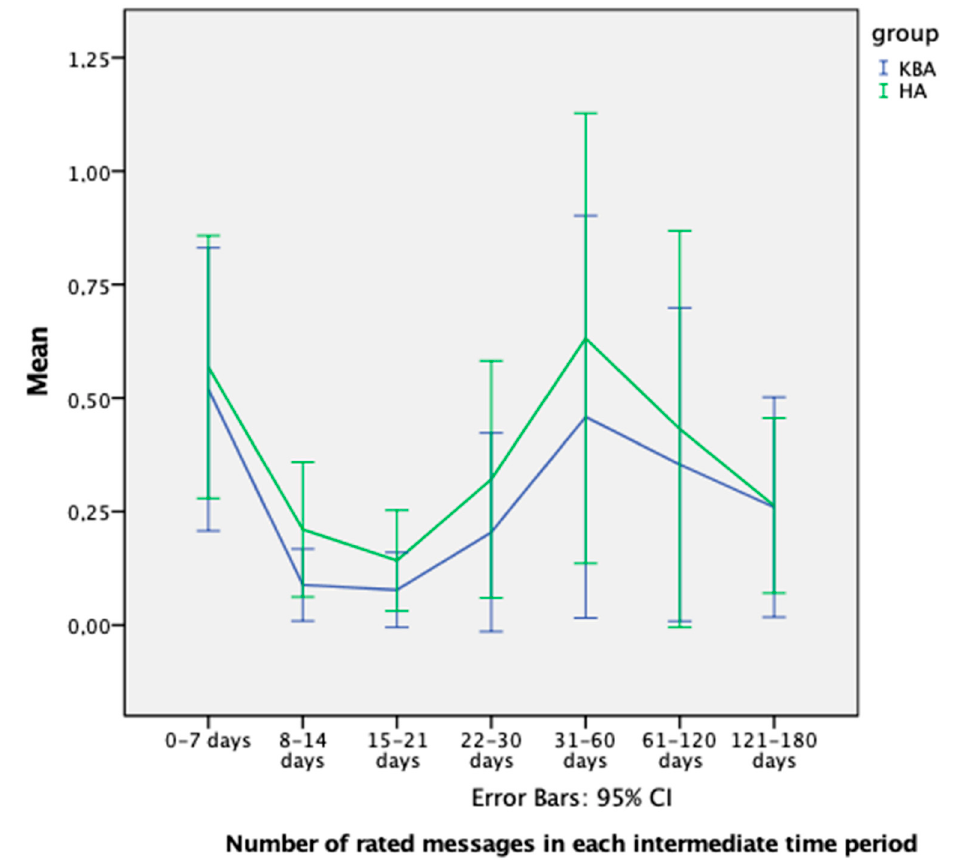
Figure 4. Evolution of the number of rated messages (higher is better).